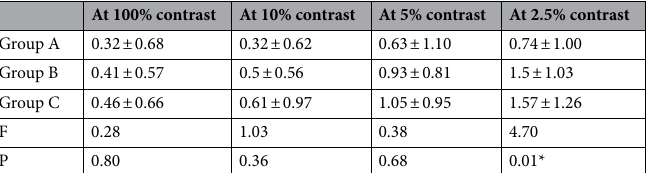
At 100% contrast At 10% contrast At 5% contrast At 2.5%